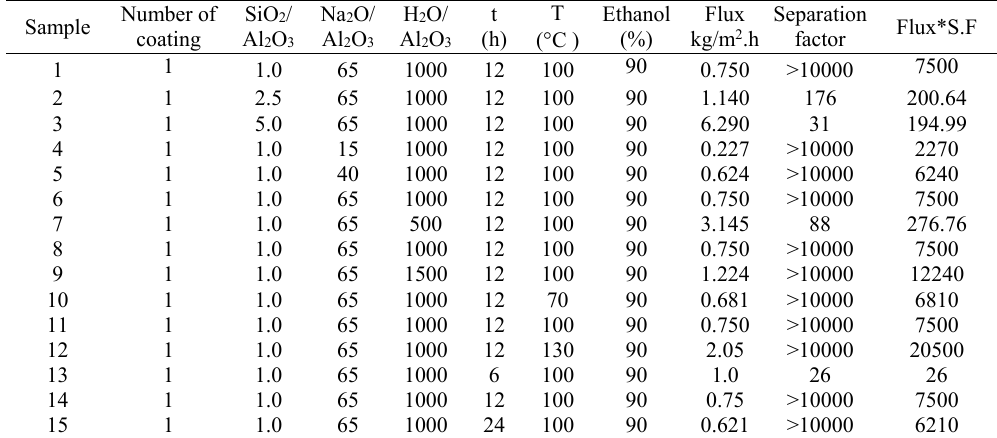
Table 2 Flux and separation factor of HS zeolite membranes Table 2: Flux and separation factor of HS zeolite Sample